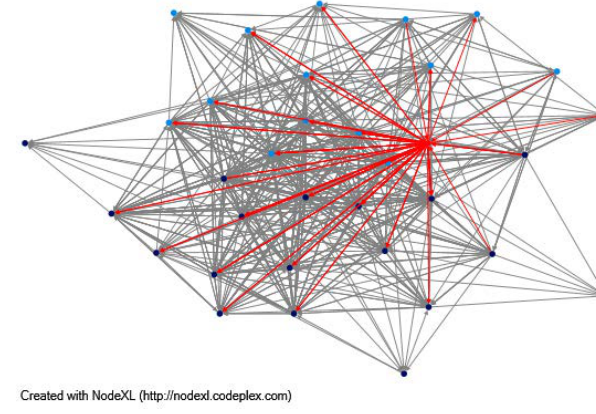
Figure 2b. An egocentric network of “lurker” becoming a “gradually mastering member” (final four weeks)